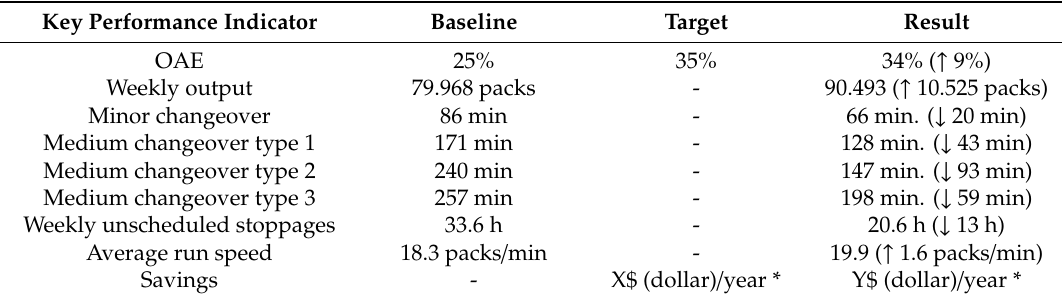
Table 1. LSS (Lean Six Sigma) algorithm implementation results.